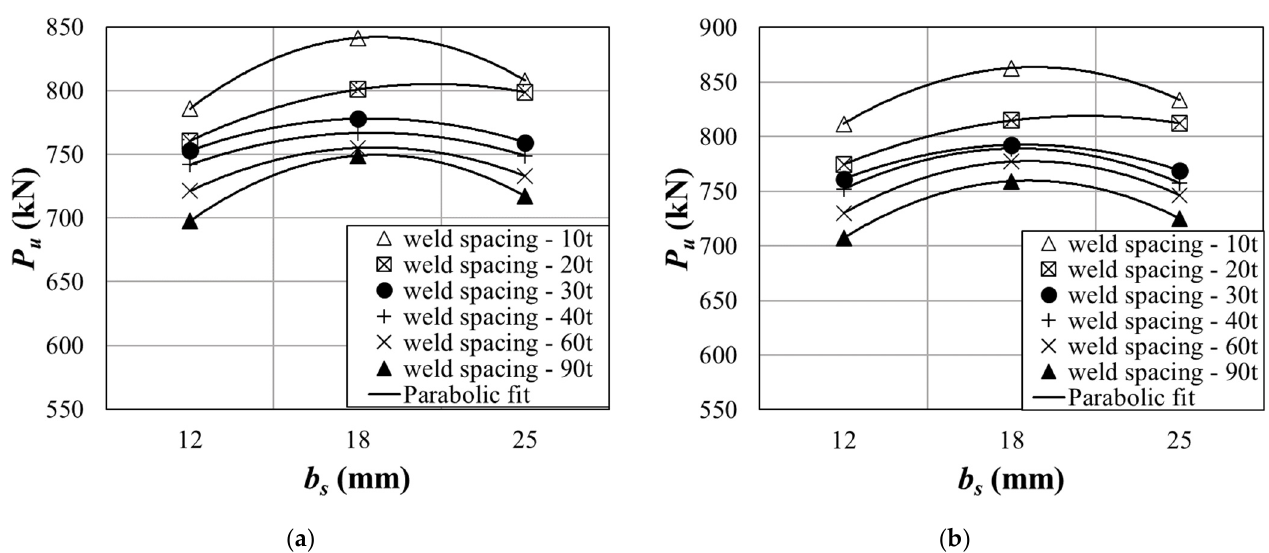
Figure 17. The effect of different stiffener widths on the performance of the square CFDST . ( a ) t s = 2.3 mm, ( b ) t s = 2.8 mm.